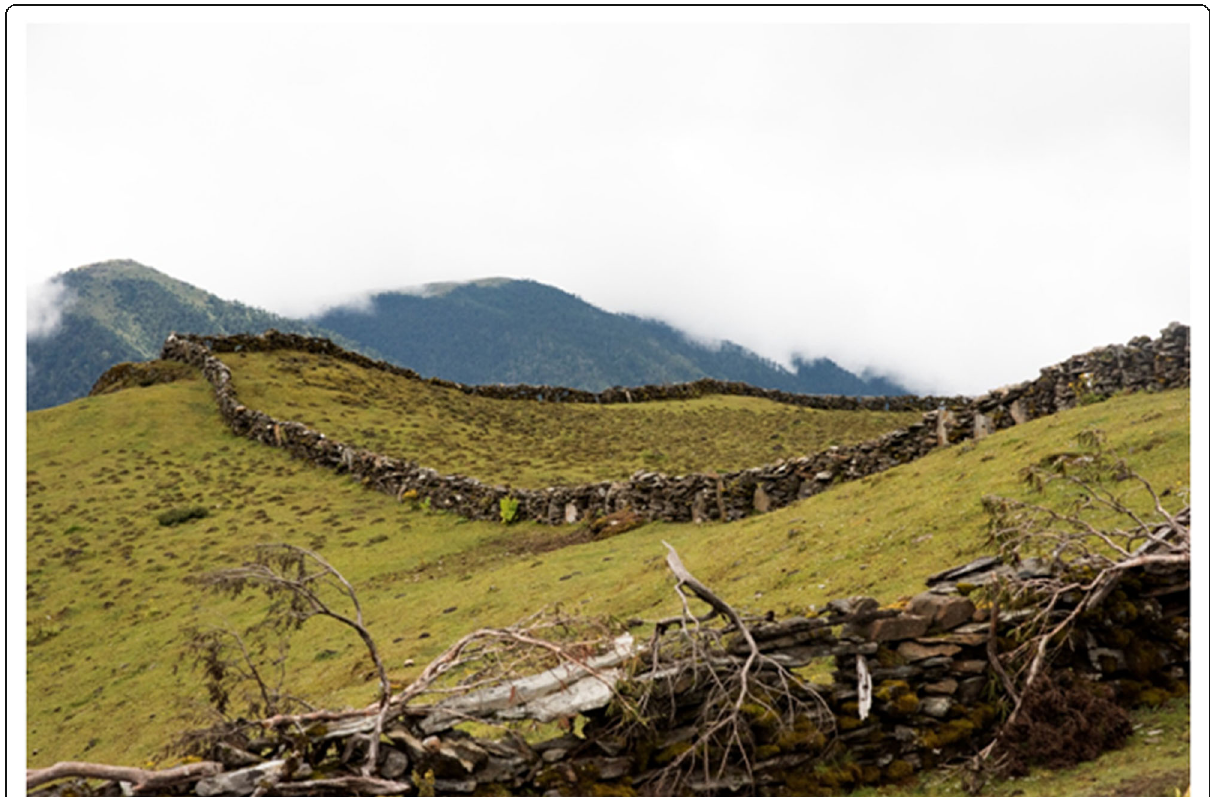
Figure 4 The tsamdro border wall expanding through the grazing ridge at an altitude of 4,000 masl between Merak and